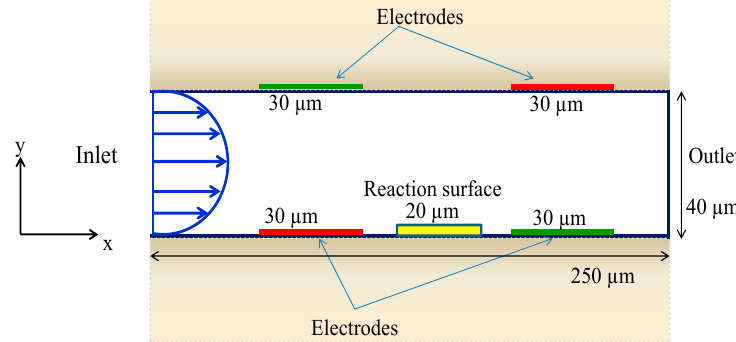
Figure 1. Schematic model geometry of the microchannel of the biosensor.